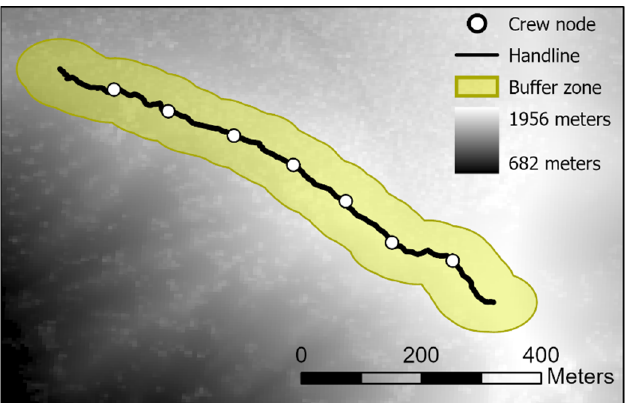
Figure 5. Buffer zone showing the area over which handline landscape metrics are calculated. Handline 2021-07-23 used as example. The background is the 5 m DSM.